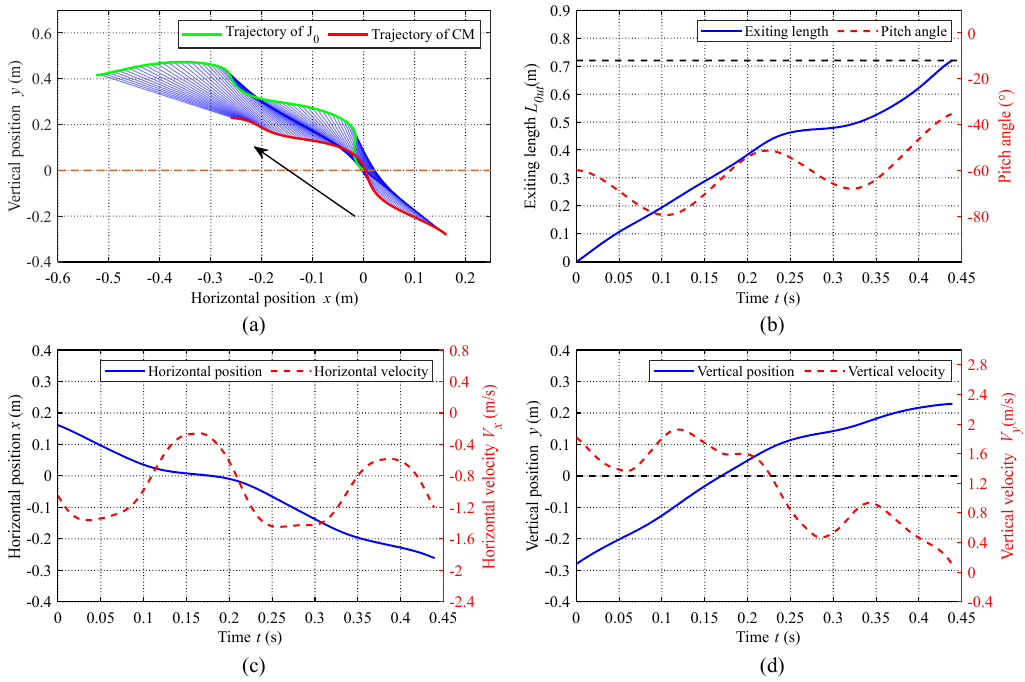
Figure 10. Curves of state variables during water-exiting phase with V e = 2.1 m/s and θ e = − 60 ◦ . ( a ) Trajectories of J 0 (green curve) and the CM (red curve). ( b ) Pitch angle and exiting length of the robotic dolphin. ( c ) Position and velocity in the horizontal direction. ( d ) Position and velocity in the vertical